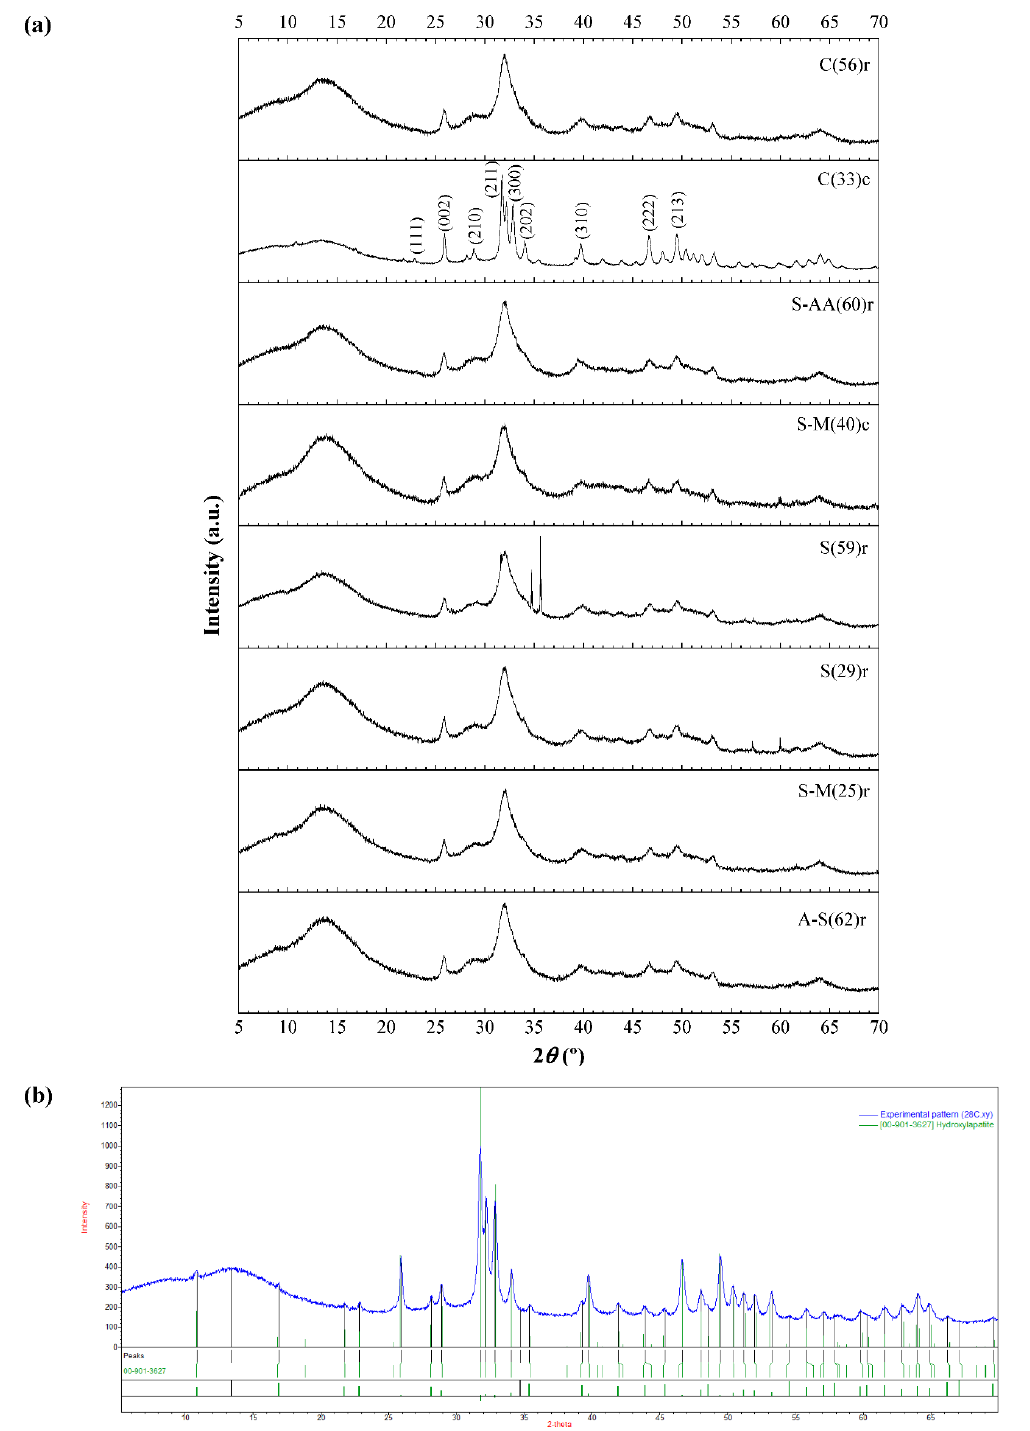
Figure 5. ( a ) Dffractograms of enamel from crown (“c”) and tooth root cementum (“r”). The conditions of patients’ teeth are indicated as follows: alcohol (A); smoker (S); treatment with psychotherapeutic drugs (M); anti-inflammatory drugs (AA); control (C). The age of the patient is shown in parentheses. ( b ) Comparison of the X-ray powder diffraction patterns of the #C(33)c sample and